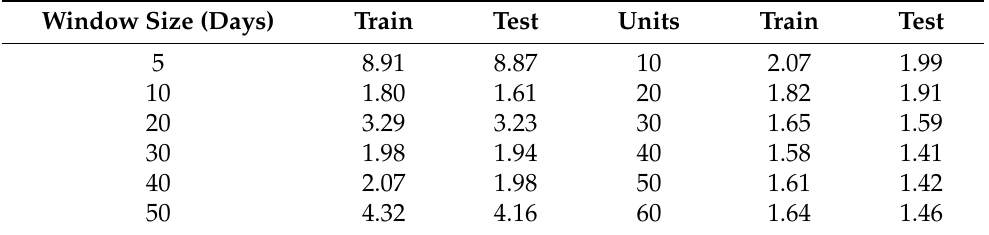
Table 5. The magnitude of RMSE errors in the test and training set, using two samples per day. Window Size